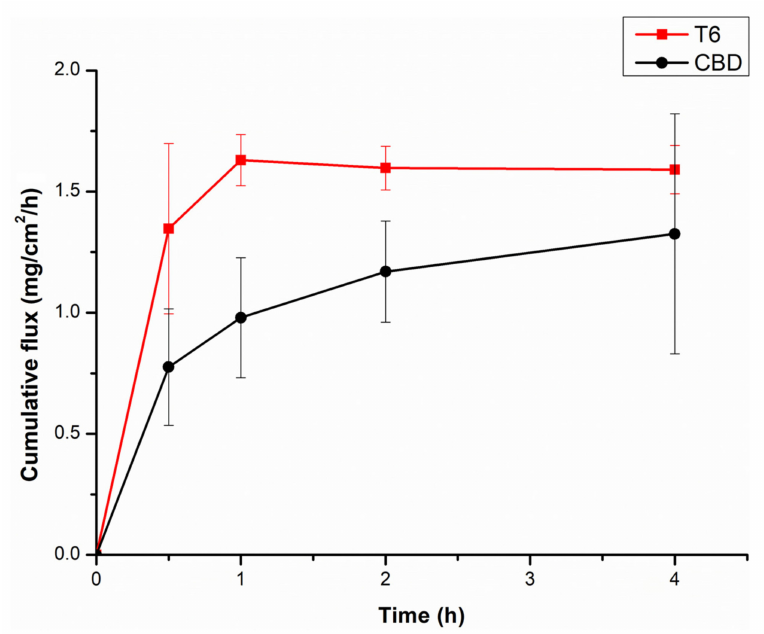
Figure 6. Cumulative permeation of pristine CBD and optimized CBD-loaded transferosomes across excised colorectal membrane (T6) over a period of 7 h at 37 ◦ C. ( n = 3).